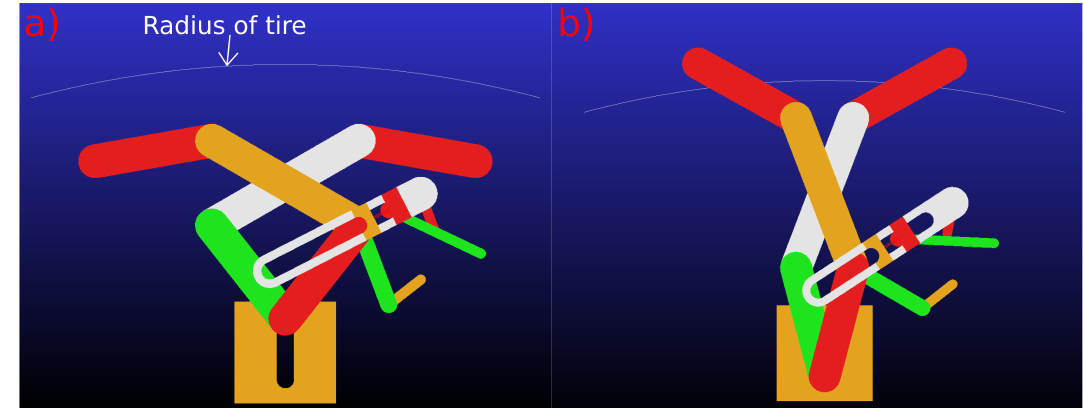
Figure 17. Model of proposed mechanism developed in MSC Adams ( a ) closed position; ( b ) open